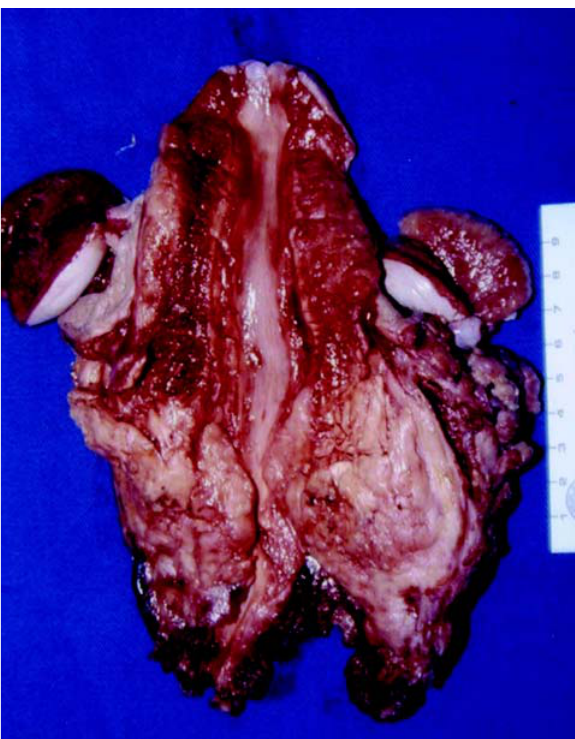
Figure 2 – Emasculation. Resection of the entire penis and scrotum.